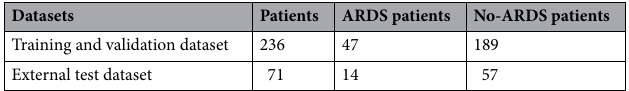
Table 7. Details of modeling